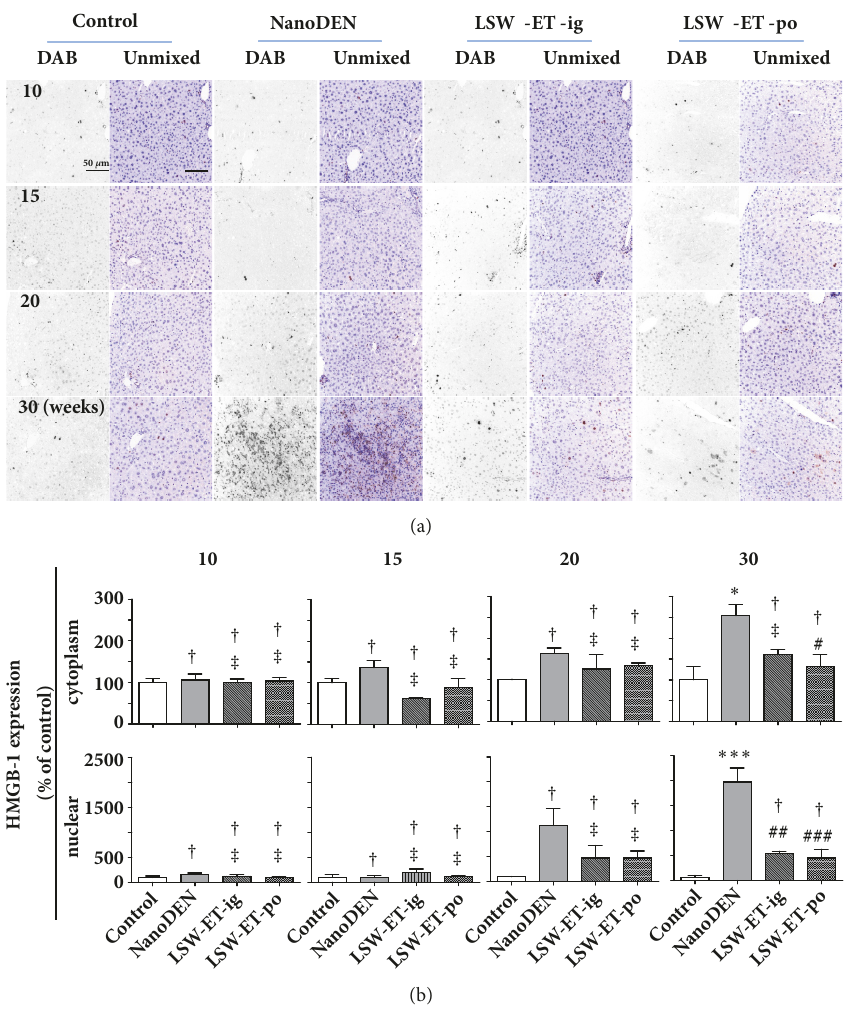
Figure 7: Oral application of L S W-ET decreased the nano D EN-induced HMG B -1 expression in mice. (a) Expression of HMGB-1 by immunohistochemistry. Scale bar, 50 휇 m. (b) Quantitative expression of the cytoplasmic and nuclear expression of HMGB-1 determined by